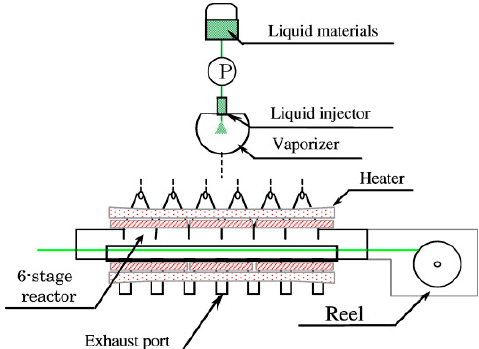
Figure 2. Schematic chemical vapor deposition (CVD) setup, mechanical parts, and operation mechanism [23]. mechanism